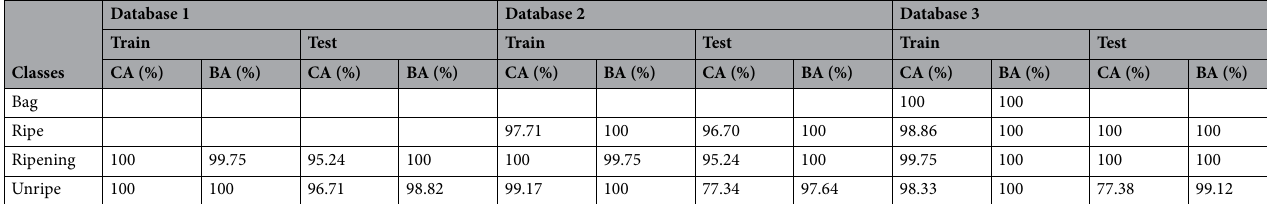
Table 1. Test results using various training databases. (CA: classification accuracy; BA: box selection